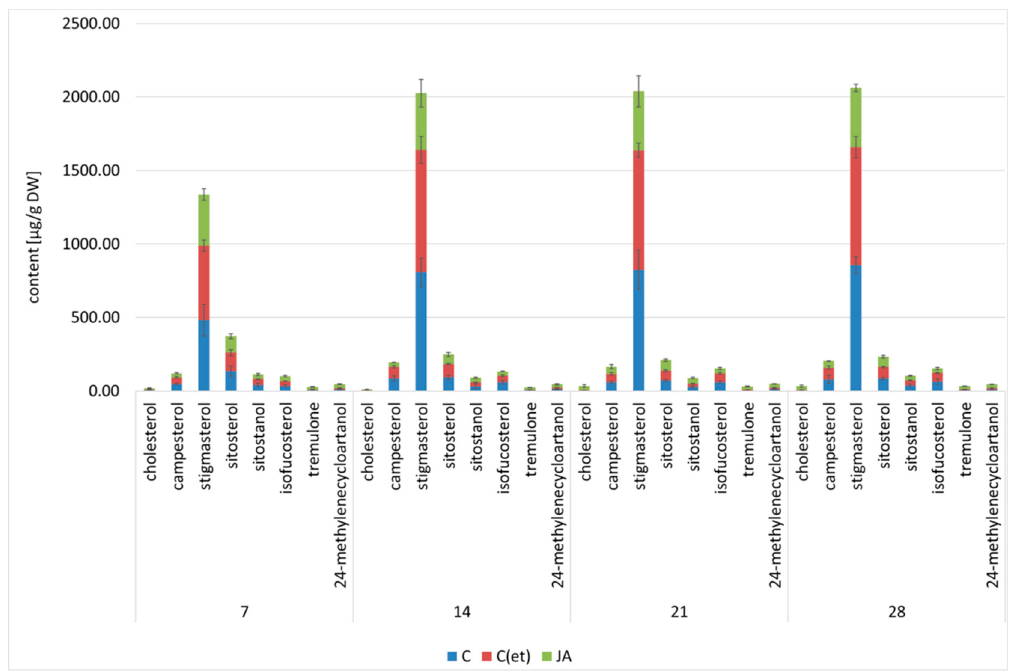
Figure 5. The effect of jasmonic acid on steroid content. C—control, C(et)—control samples sup- plemented with 70% ethanol, JA—jasmonic acid-elicited samples. See detailed data and statistical significance in Table S2.